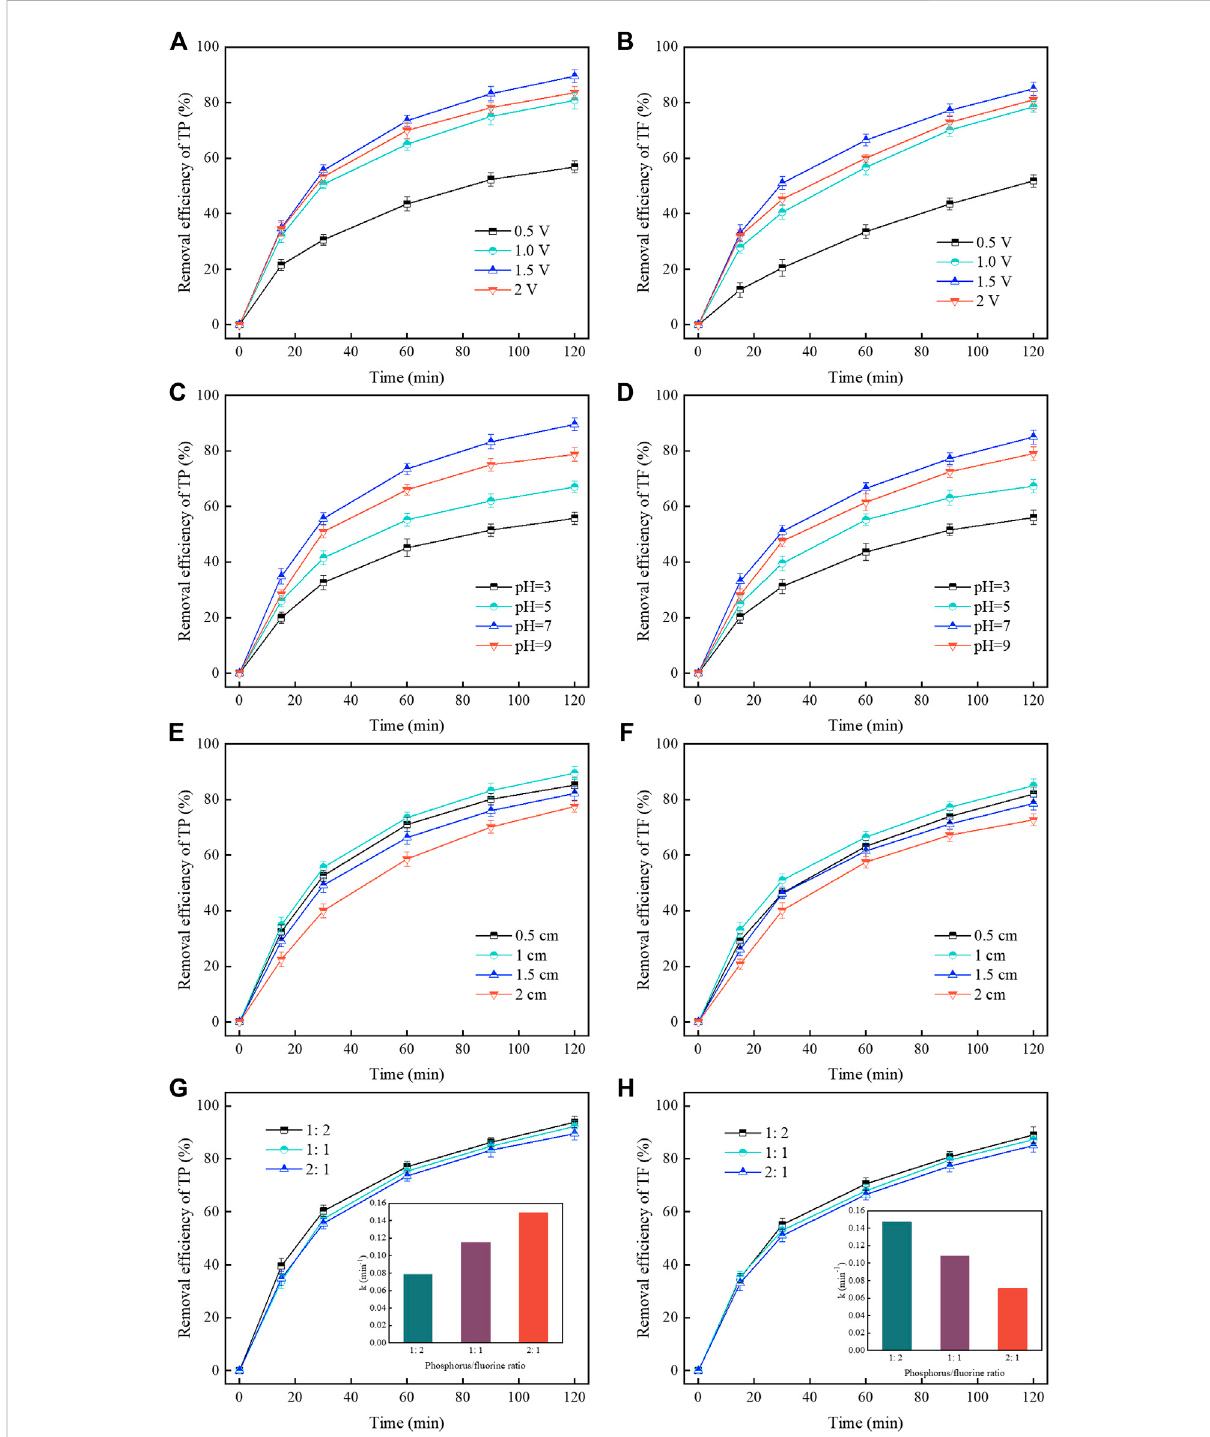
The effect of voltage intensity on removal ef fi ciency: (A) TP. (B) TF. The effect of pH on removal ef fi ciency: (C) TP. (D) TF. The effect of plate spacing on removal ef fi ciency: (E) TP. (F) TF. The effect of phosphorus/ fl uorine ratio on removal ef fi ciency: (G) TP (H)